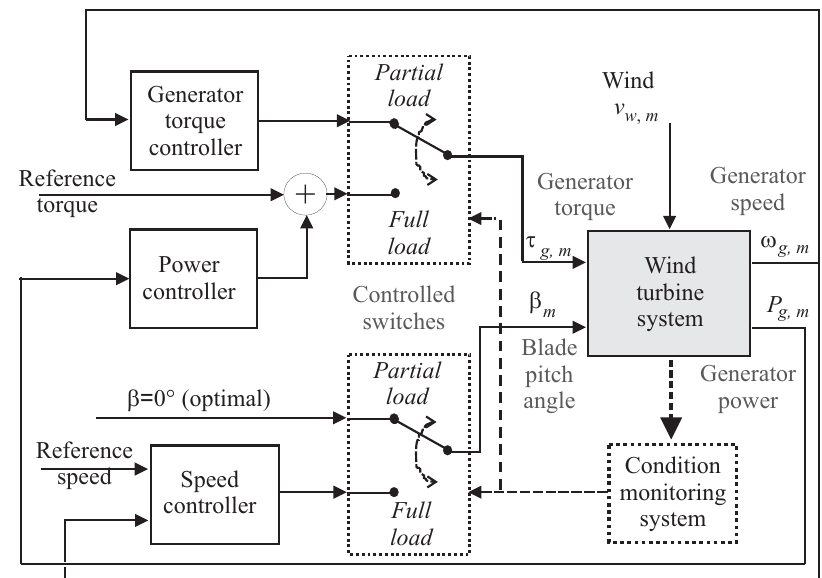
Figure 1. The WT benchmark and its main functional subsystems.